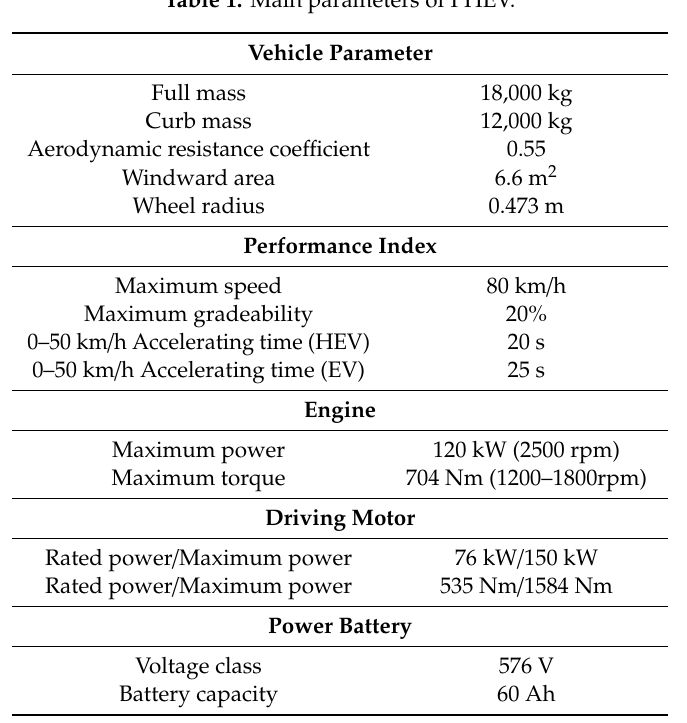
Table 1. Main parameters of